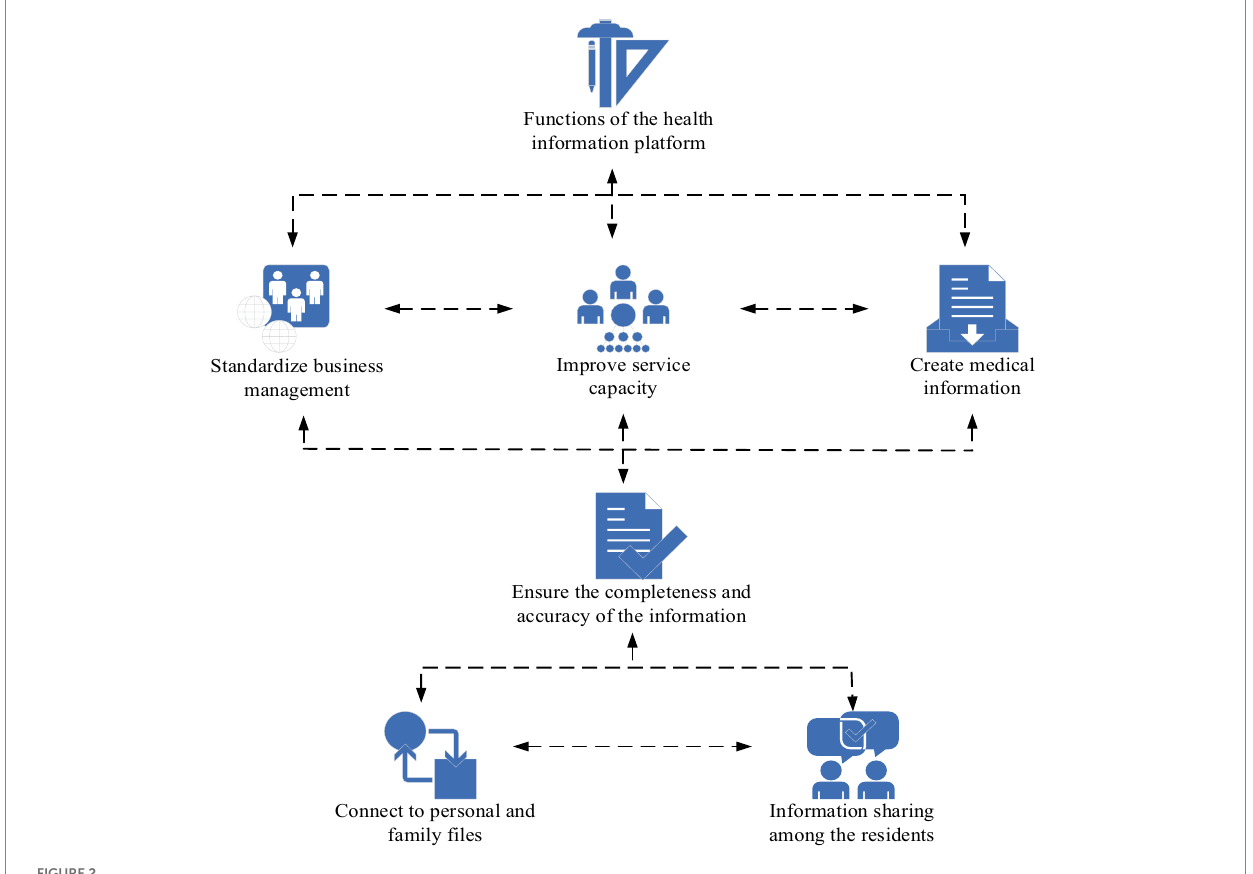
FIGURE 2 Functions of the health information platform based on community health